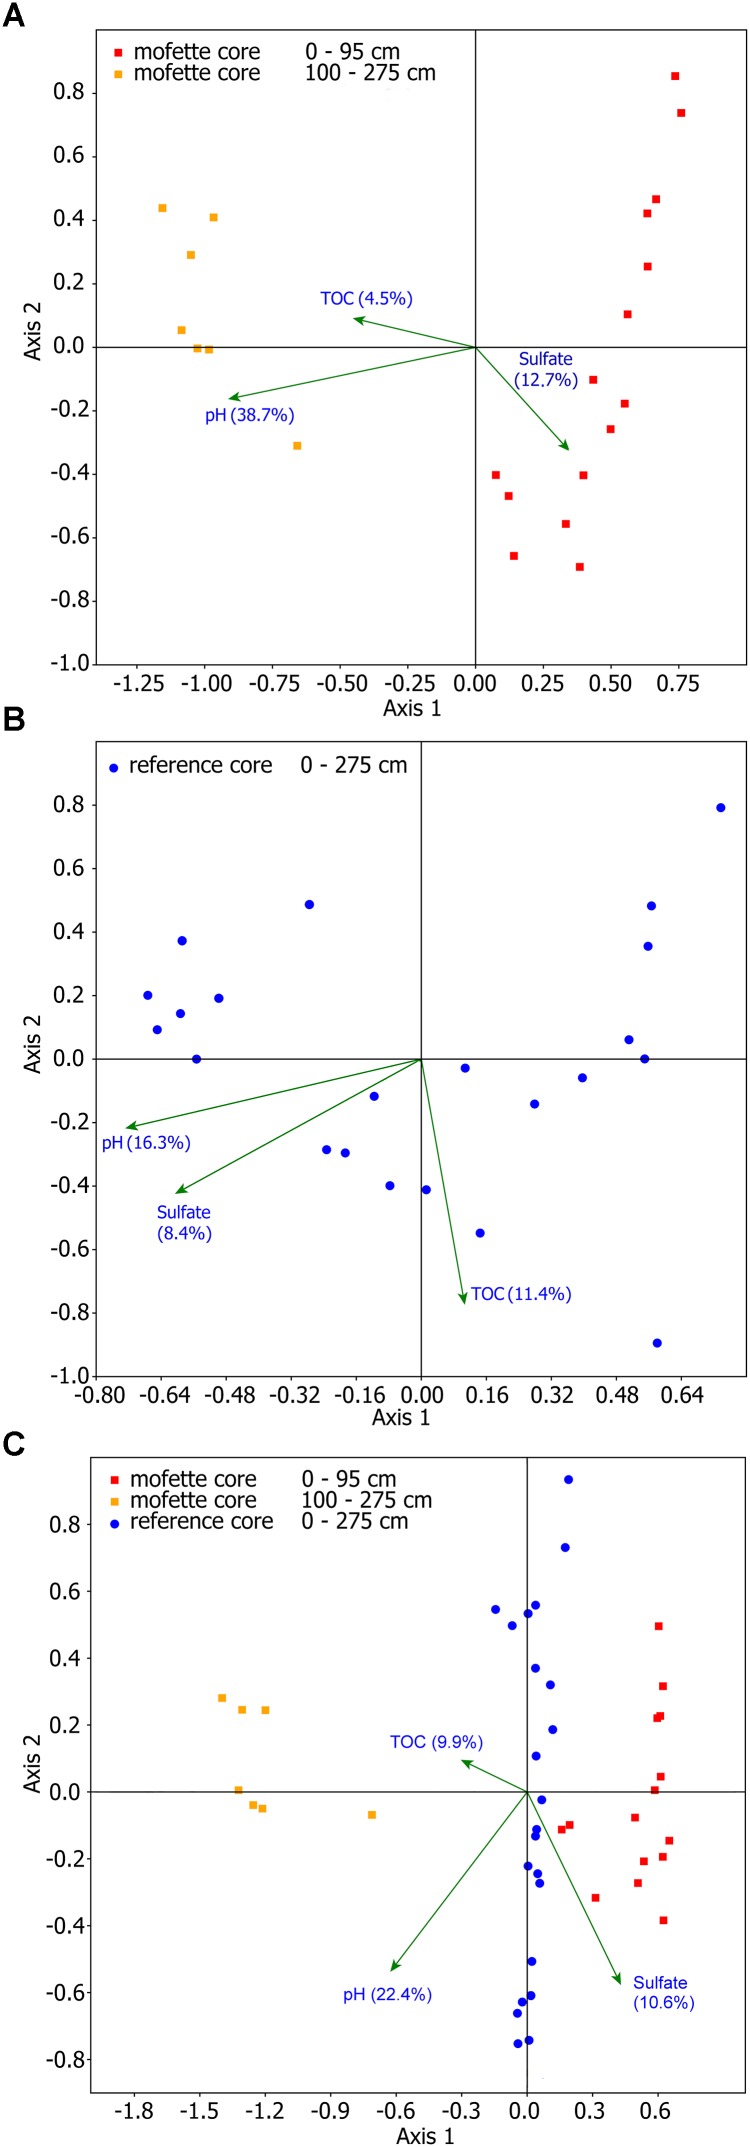
CCA analyses of the microbial communities of the mofette (A), reference site (B), and for both (C). The environmental parameters were selected based on the forward-selection method with significant padj-values (Bonferroni corrected <0.05).